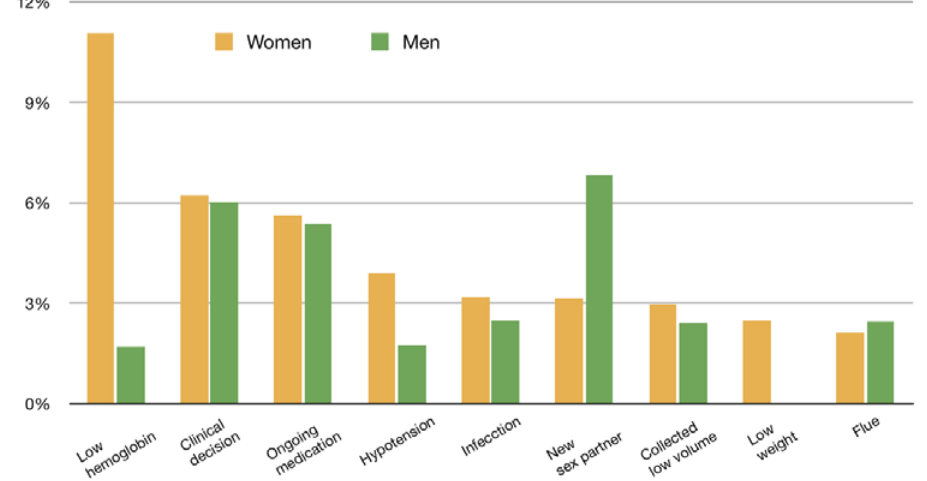
Figure 9: Top causes (> 2%) of donor rejection by gender. Low hemoglobin, Hypotension, New sex partner and Low weight are the attributes where a difference between genders is